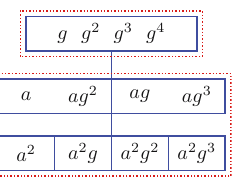
Figure 2: The eggbox picture of S 2 and its archimedean components.